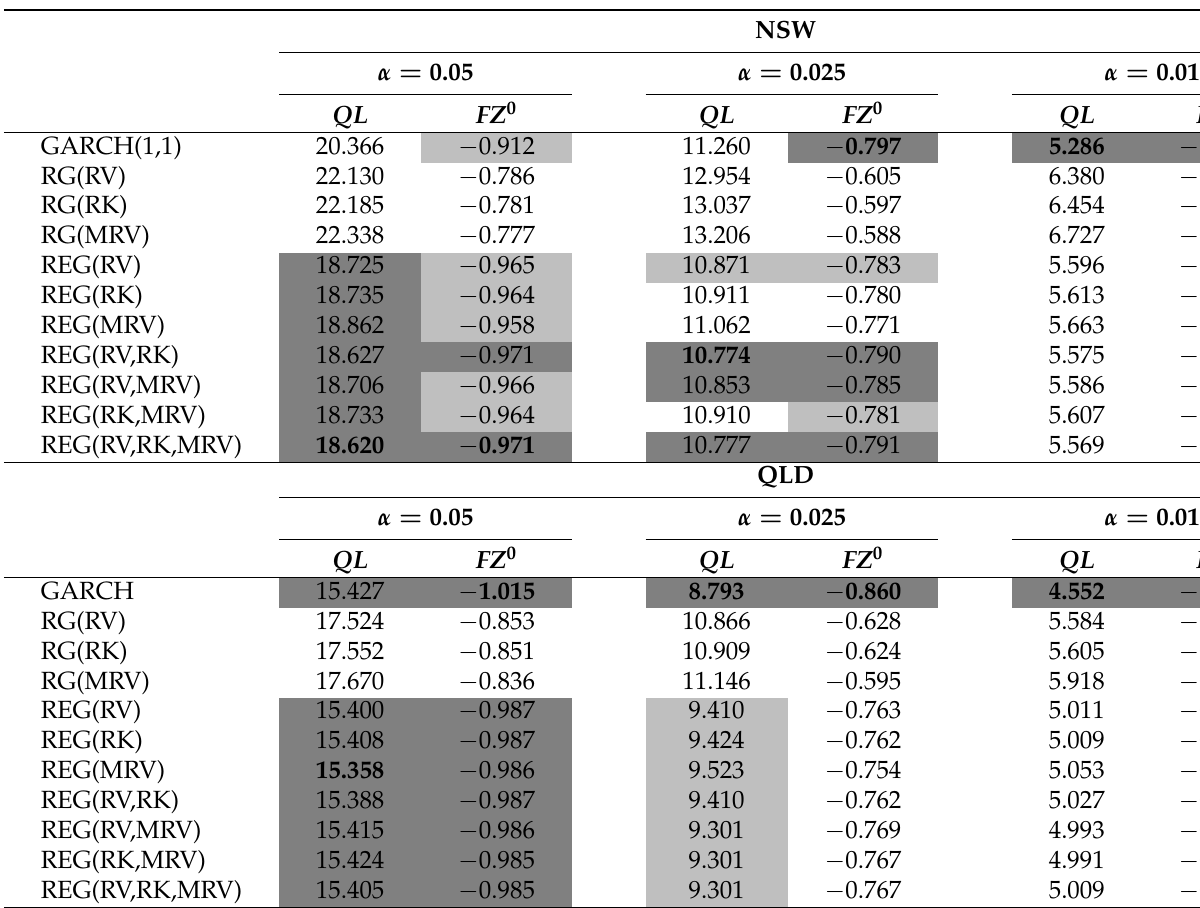
Table 6. One-step ahead Value-at-Risk and Expected Shortfall loss functions comparison: QL and FZ 0